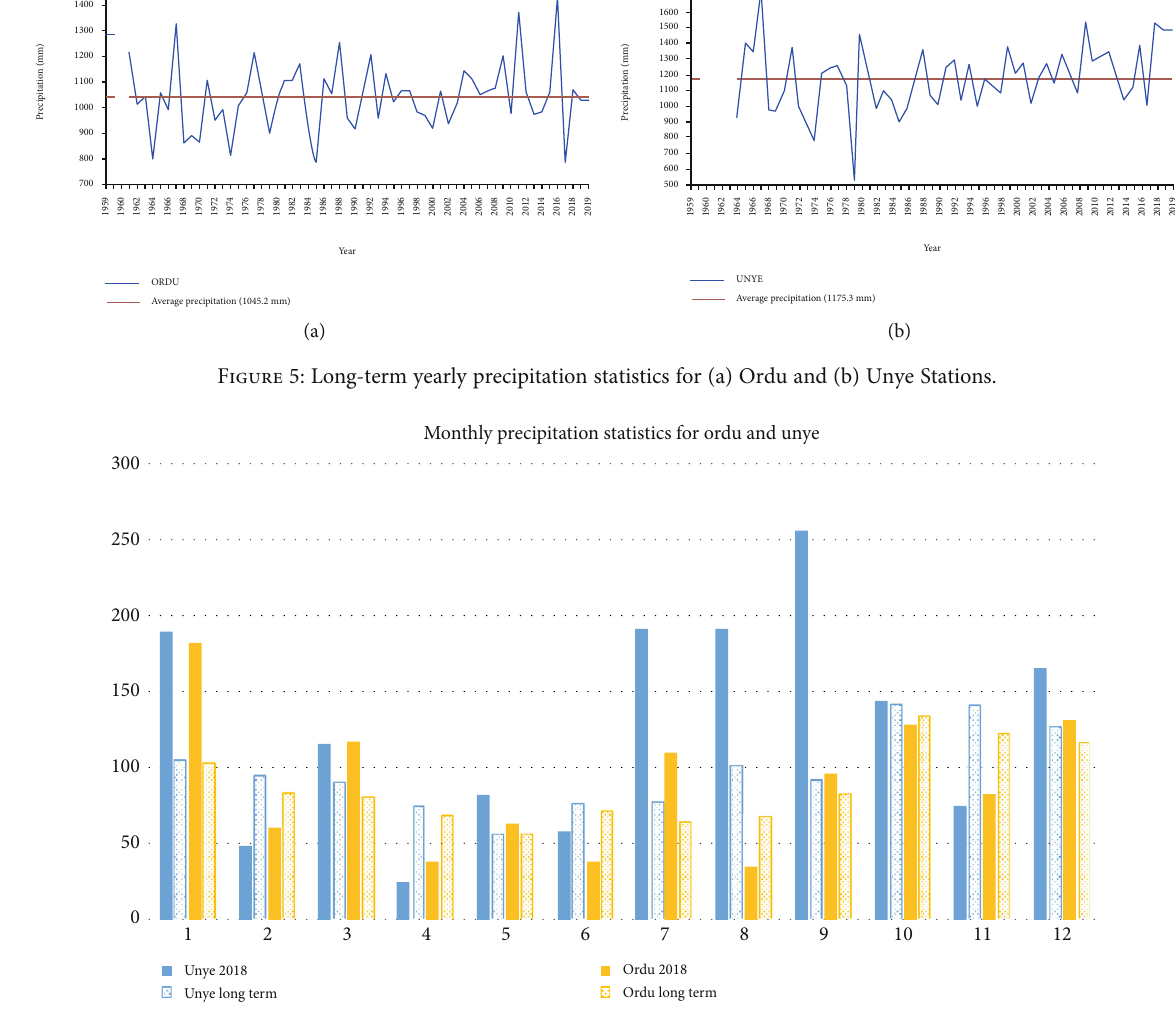
Figure 6: Long-term monthly averages and the precipitations in 2018 for Ordu and